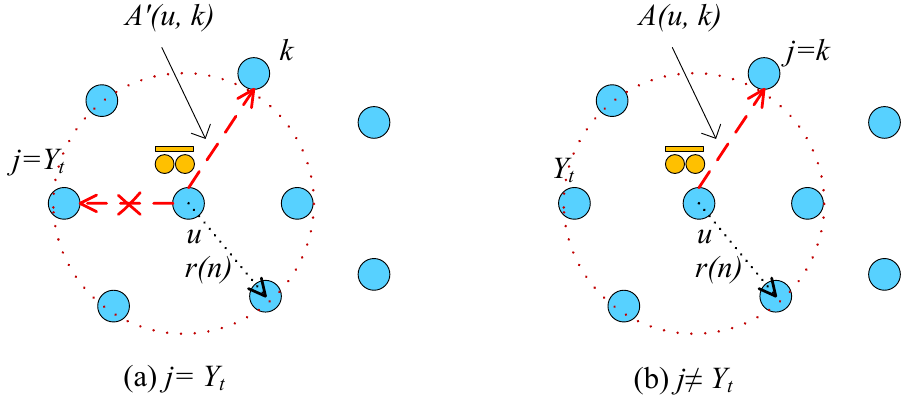
Figure 2. Illustrating two scenarios for MHDA algorithm. ( a ) The next node j is the previous visited node Y t ; ( b ) The next node j is not the previous visited node Y t